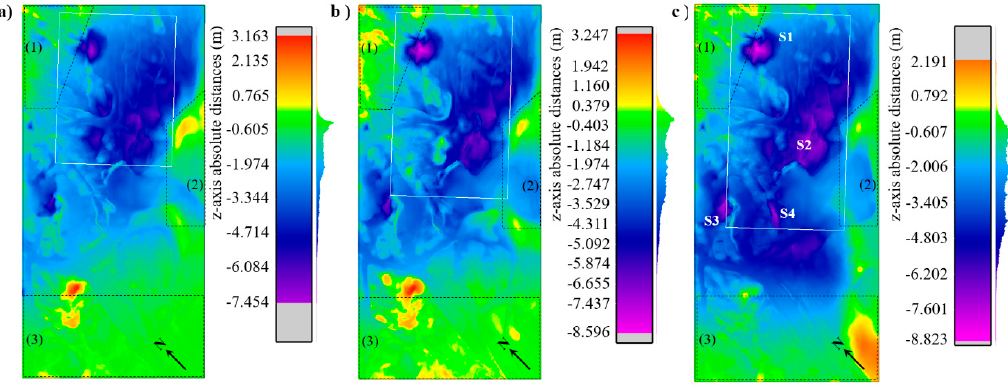
Figure 19. Monitoring data C2C comparison along z-axis: ( a ) Epoch 0–7, ( b ) Epoch 0–8, ( c ) Epoch 0– 9. The identified possible sinkholes ( c ) are S1, S2, S3, and S4.